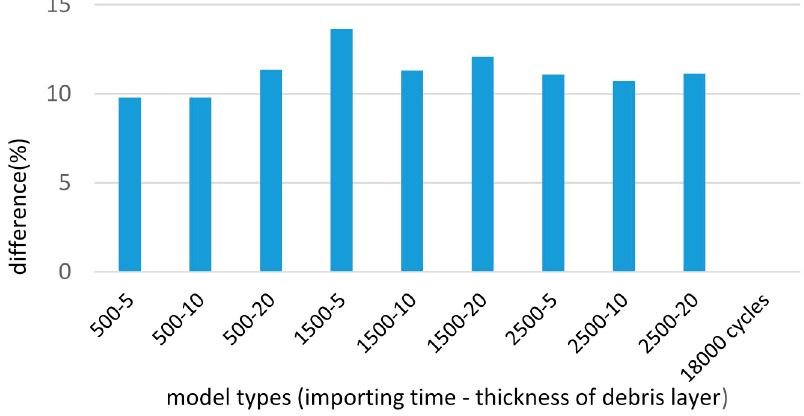
Figure 19. Difference of wear damage compared to the case of basic model, after 18,000 cycles.